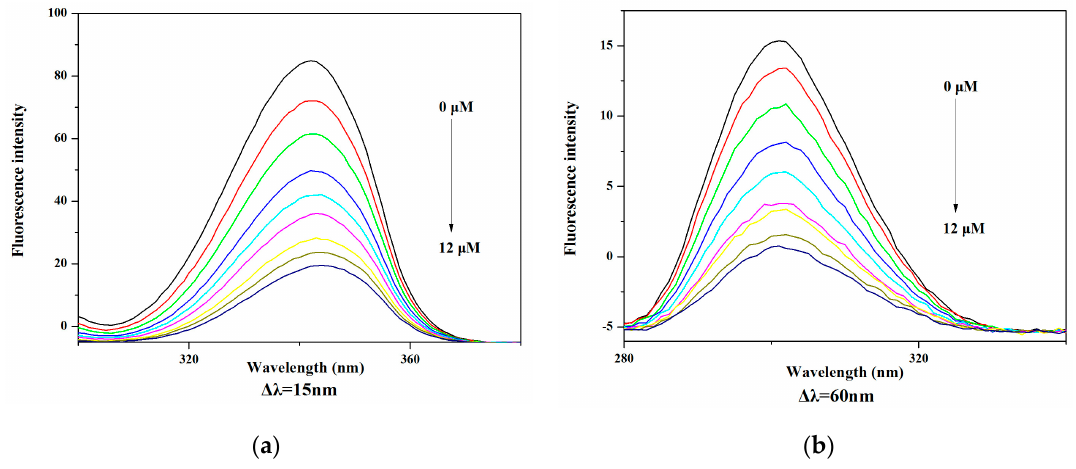
Figure 11. The synchronous fluorescence spectra of BSA (0.5 μ M) in the presence of different concentrations of V 18 (0, 1.33, 2.67, 4.00, 5.33, 6.67, 9.33 10.67, 12 μ M): ( a ) Δλ = 15 nm and ( b ) Δλ = 60 nm at 20 °C in PBS.